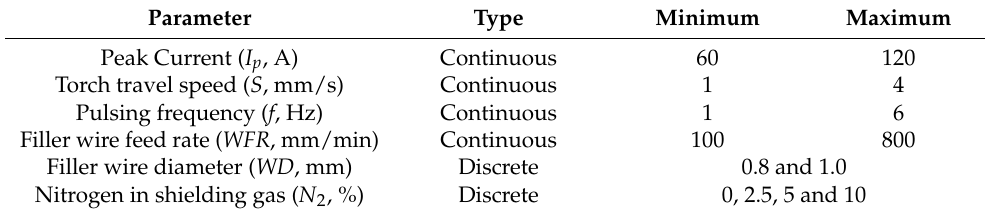
Table 3. Minimum and maximum values of the parameters used for welding 1.5 mm thick sheets. Parameter Type Minimum Maximum Peak Current ( I p , A) Continuous 60 120 Torch travel speed ( S , mm/s) Continuous 1 4 Pulsing frequency ( f , Hz) Continuous 1 6 Filler wire feed rate ( WFR , mm/min) Continuous 100 800 Filler wire diameter ( WD , mm) Discrete 0.8 and 1.0 Nitrogen in shielding gas ( N 2 , %) Discrete 0, 2.5, 5 and 10